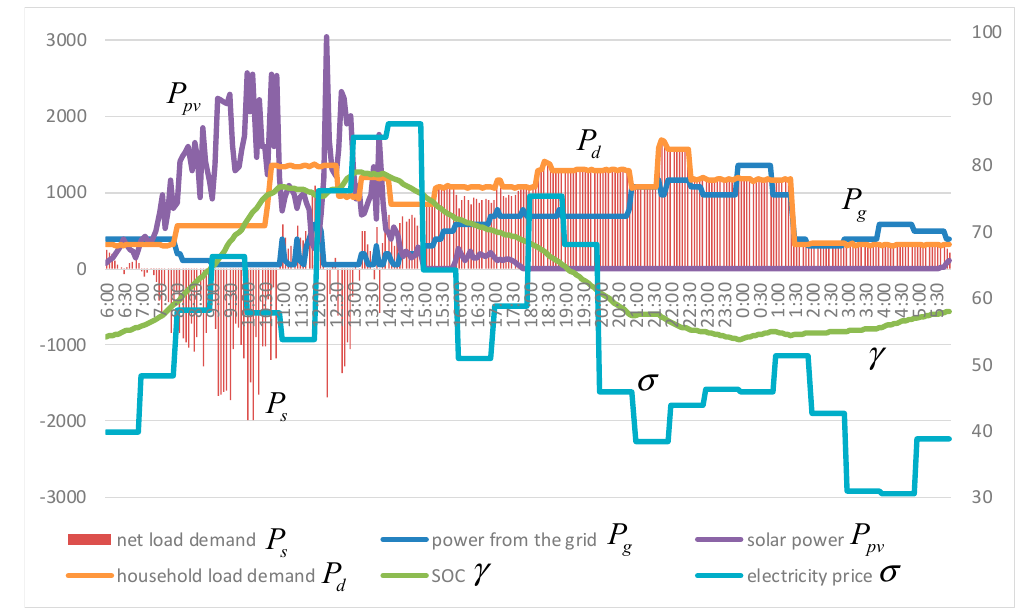
Figure 4. Output of fuzzy controller for the second scenario (cloudy day).